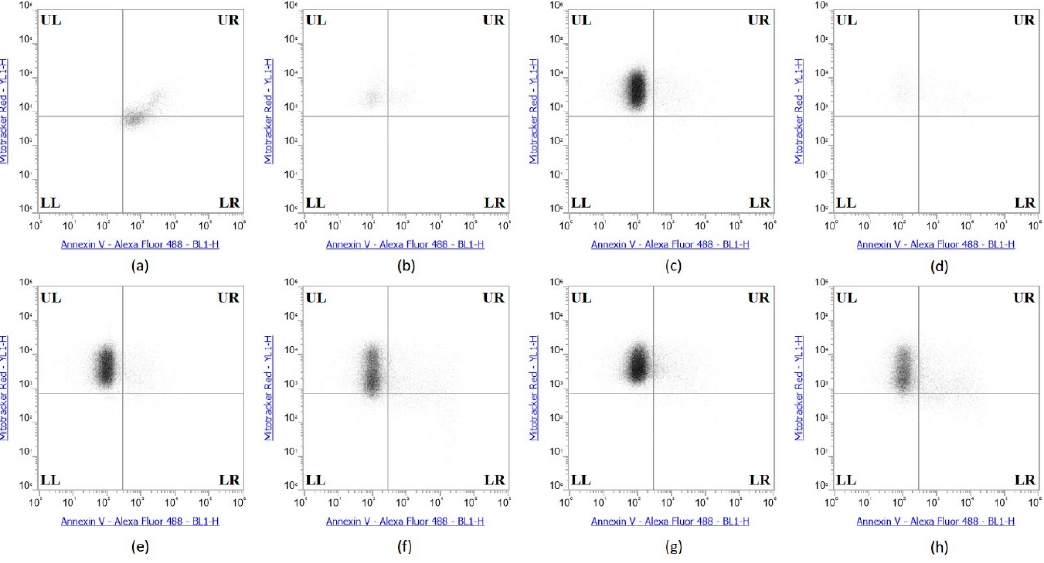
Figure 11. Se-Immunoconjugates induced no apoptosis in HME50-5E Cells. ( a ) Sutent (apoptosis control), ( b ) 0.1% Triton X-100 (necrosis) control), ( c ) Control untreated, ( d ) Selenite, ( e ) Bevacizumab, ( f ) Selenobevacizumab, ( g ) Trastuzumab, ( h ) Selenotrastuzumab treatments in HME50-5E cells. HME50-5E cells were stained with Annexin V/PI Mitotracker Red and subjected to flow cytometric analysis. The four quadrants represent—living cells (Upper Left; UL: Annexin V, Mitotracker Red), early apoptotic (Upper Right; UR: Annexin V, Mitotracker Red), late apoptotic (Lower Right; LR: Annexin